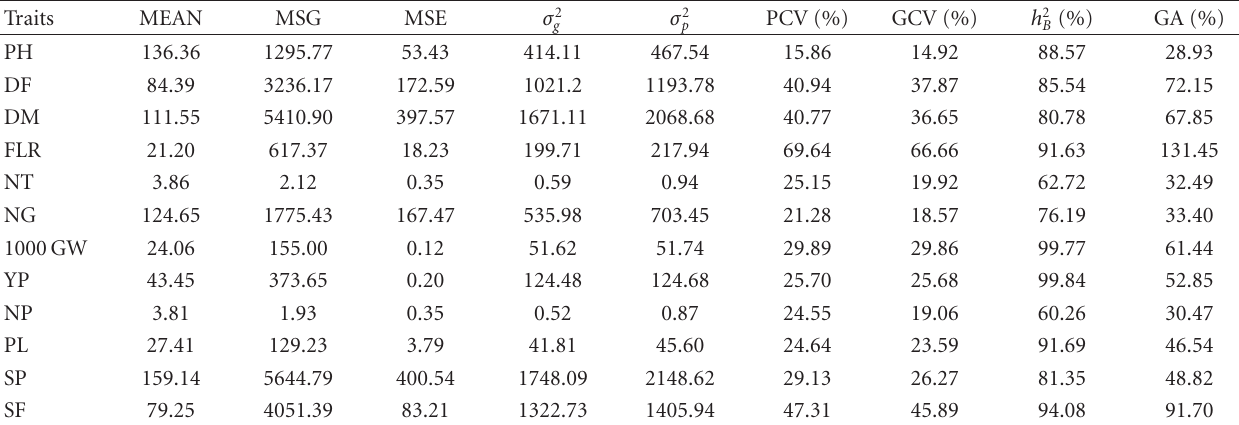
Table 5: Genetic variance of 12 morphological